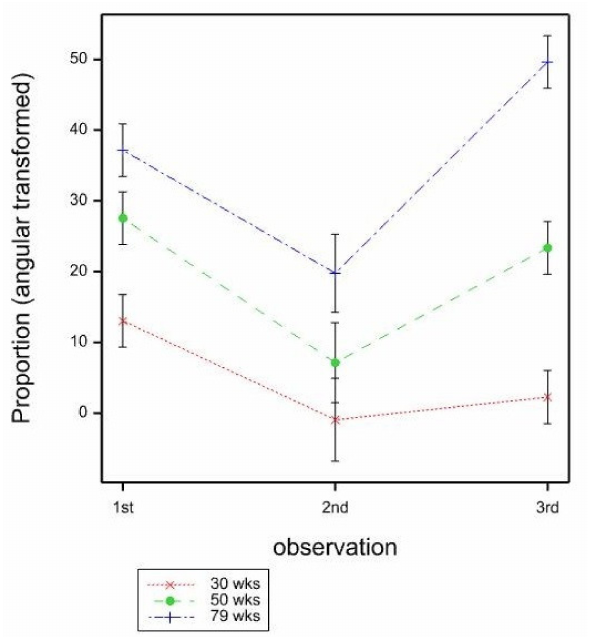
Figure 4. Mean proportions of hens sitting on the mats by age (30, 50, 79 weeks) and observation (1st, 2nd, 3rd) estimated from LMM. Mean SE